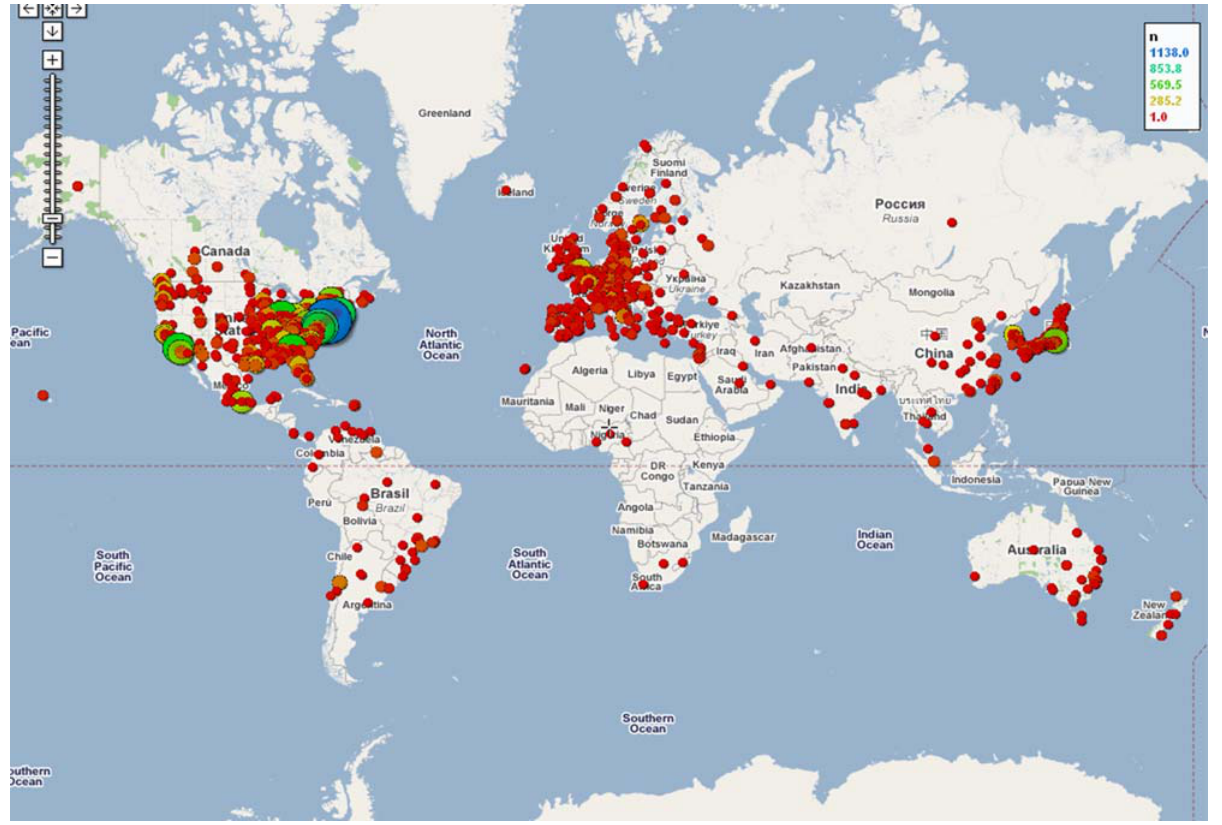
Figure 3. Geographical distribution of the raw number of SFN abstract authors for 2006 displayed on a Google Map. The locations with the most representation are indicated by dark blue, followed by green, yellow, and finally red, circles.